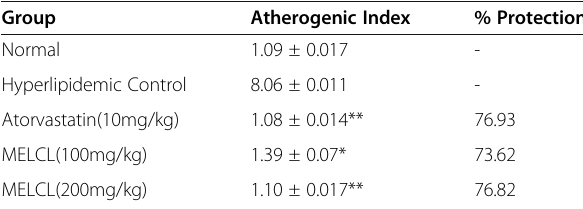
Table 3 Effect of MELCL on atherogenic index and percentage protection of various groups